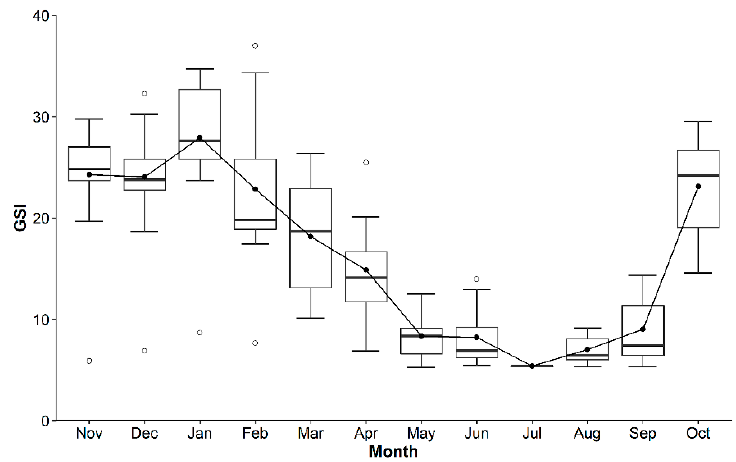
Figure 4. Box and whiskers plot of monthly variation of gonadosomatic index (GSI) of green mussel Perna viridis collected from the coastal water of Bangladesh during November 2017 to October 2018.